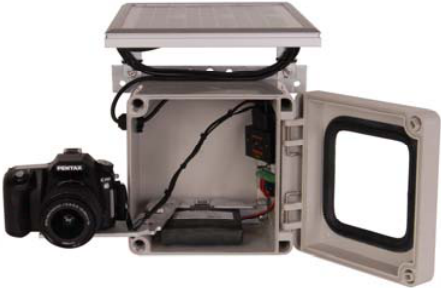
Figure 2: Harbortronics time lapse camera package